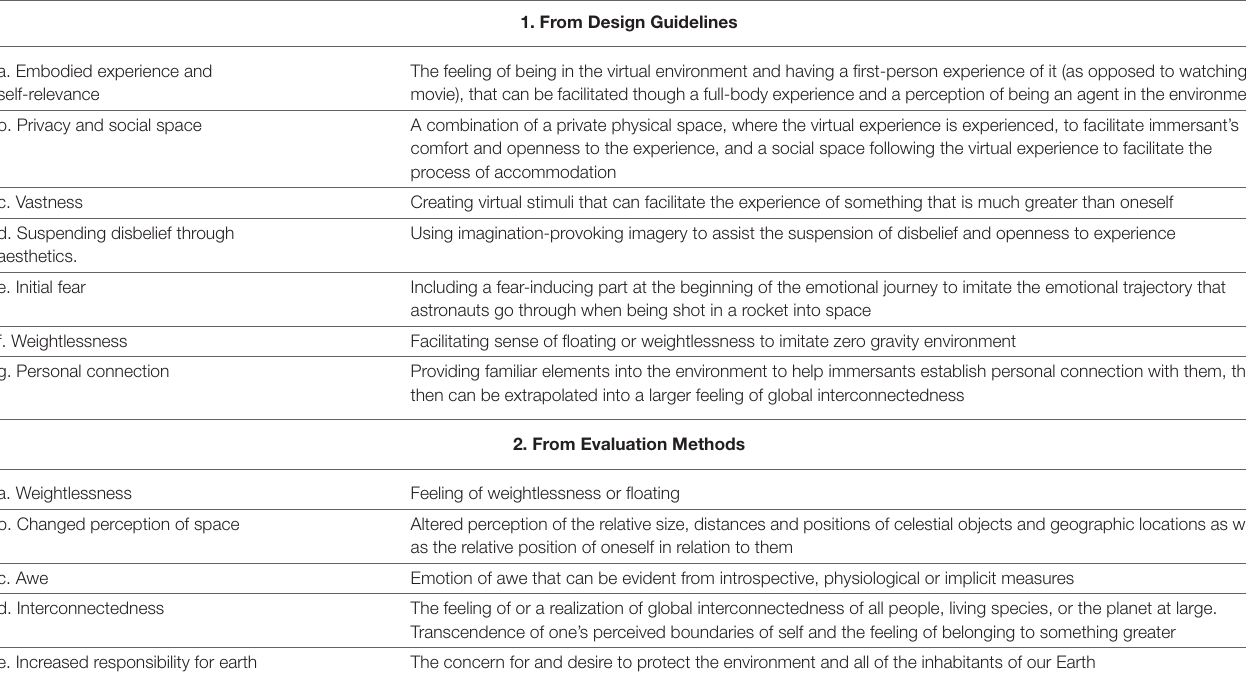
TABLE 2 | Selected design and evaluation guidelines for design of the virtual experience of the Overview Effect from Stepanova et al.